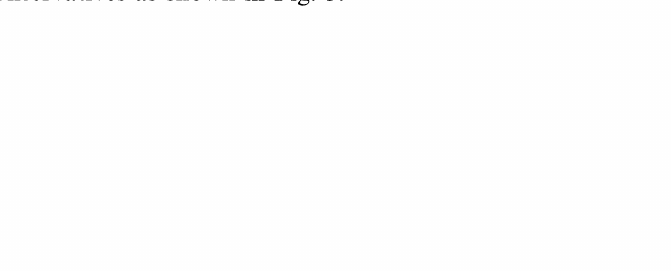
FIGURE 3 Structural